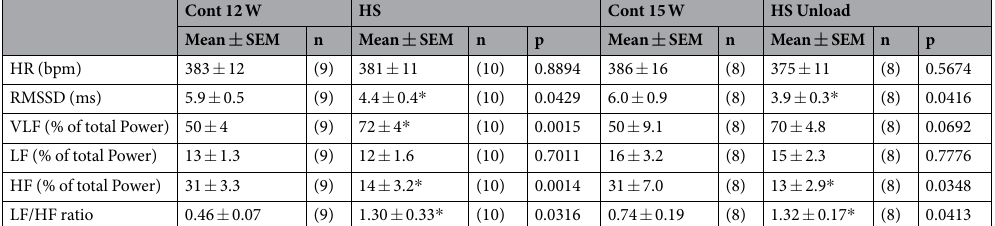
intake higher than 3 times the recommended by the WHO 3 , which guided our choice for a 0.9% Na + content in our high sodium diet. In addition, the tonic activation of central AT 1 receptors contributes for high BP suggesting that central mechanisms activated by angiotensin II at the brain level also play an important role in this pathology.